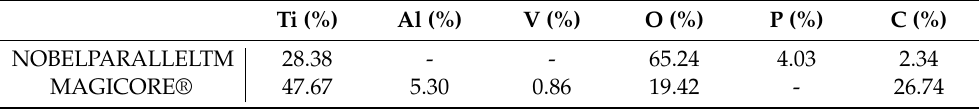
Figure 1. Implant surface morphology observed by SEM. ( a ) NB™, ( b ) MC ® , ( c ) NB™, and ( d ) MC ® . Scale bars = 50 µm and 20 µm. Table 2 . Chemical composition of the tested implant surfaces (chemical elements rate by EDX) .